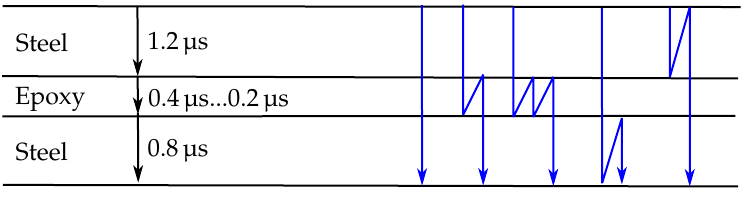
Figure 10. Reflective sites, signal paths and resulting signal time-of-flights for a mechanical wave in the closed mould process analyzed in this